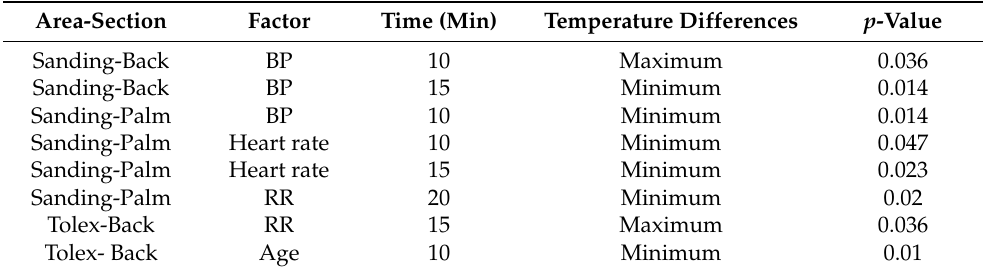
Table 7. Mann–Whitney U-test of study factors for temperature differences. Area-Section Factor Time (Min) Sanding-Back